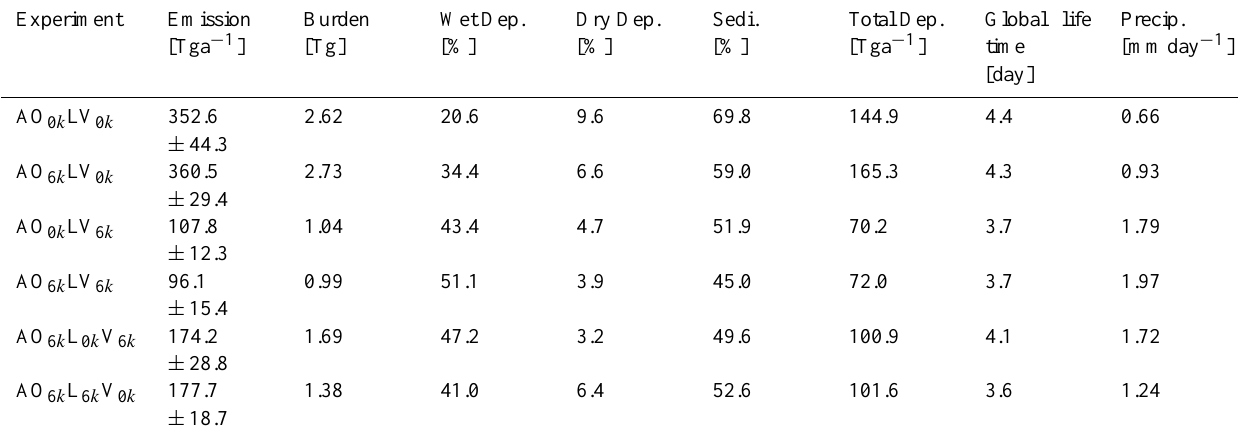
Table 6. Dust emission, burden, deposition and precipitation in North Africa (17 ◦ W–40 ◦ E; 10–30 ◦ N) and global life time of dust for altering atmospheric and ocean (AO) and land surface conditions (LV). Precip. Experiment Emission Burden Wet Dep. Dry Dep. Sedi. Total Dep. Global life [mmday − 1 ] [Tga − 1 ] [Tg] [%] [%] [%] [Tga − 1 ] time [day] AO 0 k LV 0 k 352.6 2.62 20.6 9.6 69.8 144.9 4.4 0.66 ± 44.3 AO 6 k LV 0